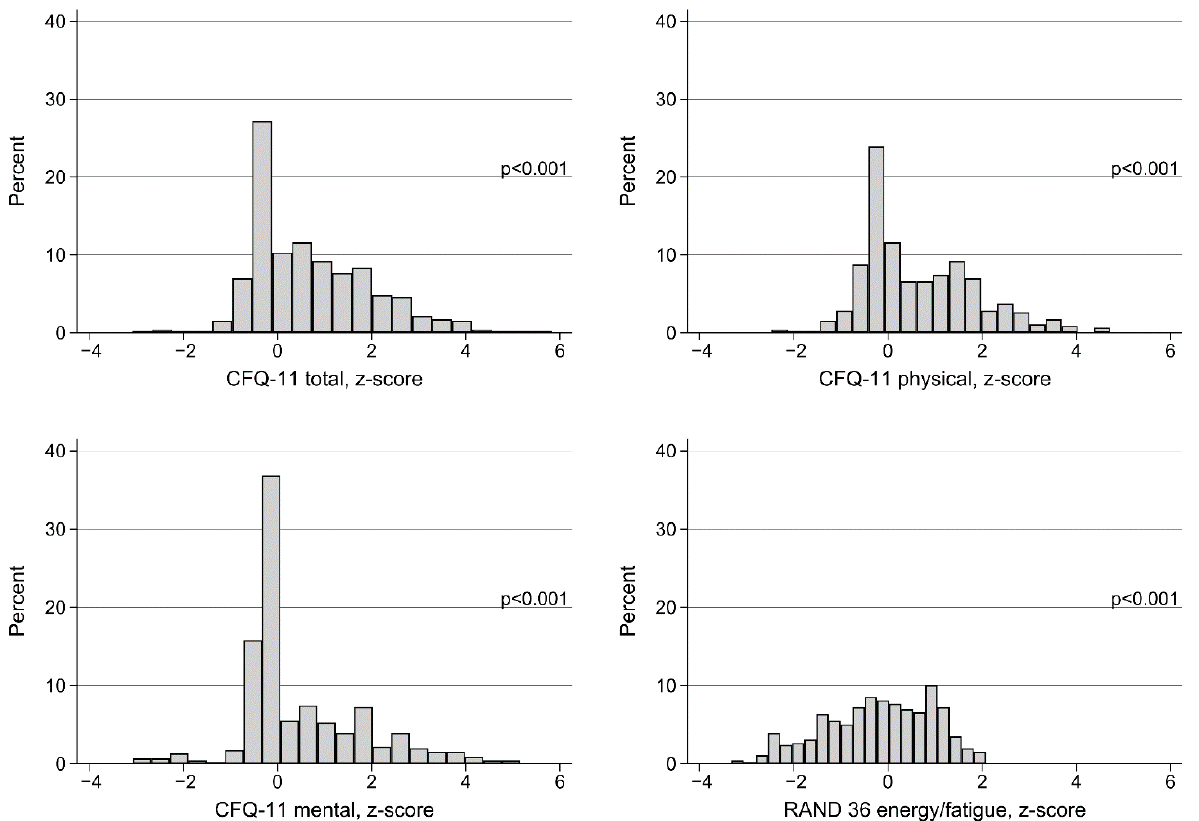
Figure 2. Fatigue and energy/fatigue scores at 1.5–6 months after start of COVID-19, z scores for comparison with age and sex-stratified normative data from Norwegian general populations. CFQ-11 = Chalder fatigue questionnaire. p -values are for comparison with z score = 0 (t-test).